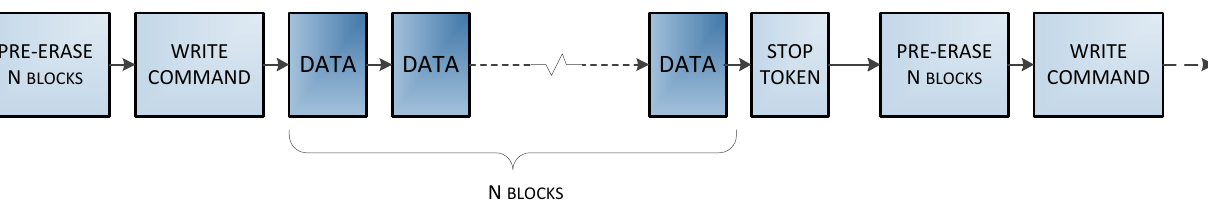
Figure 8. Multiple block write mode with